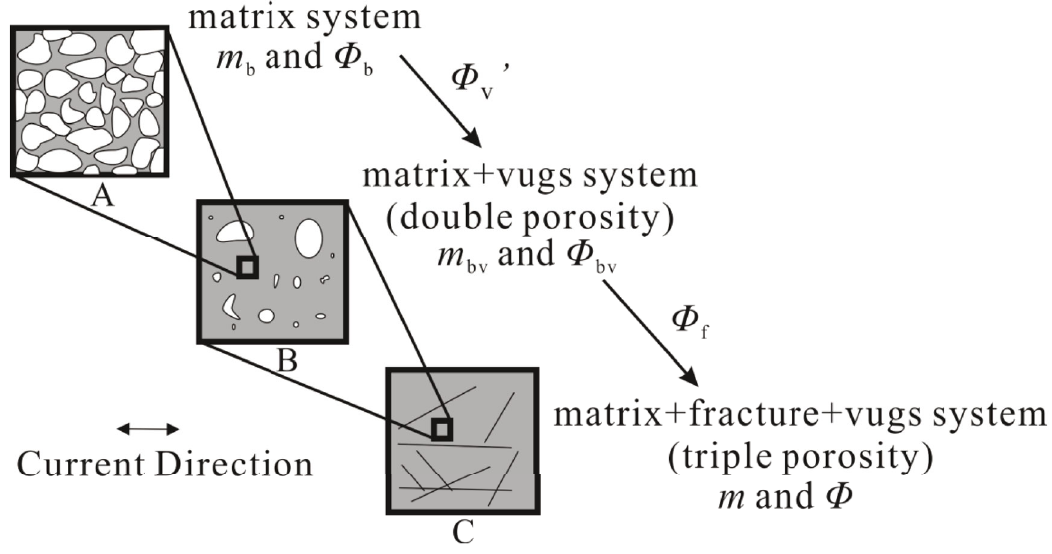
Figure 5: Calculation model and process of the m value of the triple-porosity composite system modi fi ed according to the Berg [10] calculation